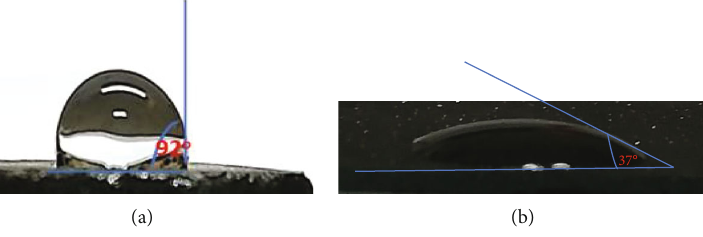
Figure 9: Contact angle values for (a) PANI and (b) PANI/Ag